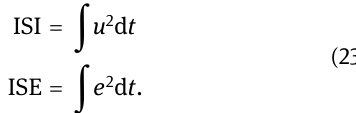
The fi ndings provided in Figures 9 and 10 clearly demonstrate that optimal performance is achieved for a fractional increase β = 0.3 compared to the other situa - tions β = 1.